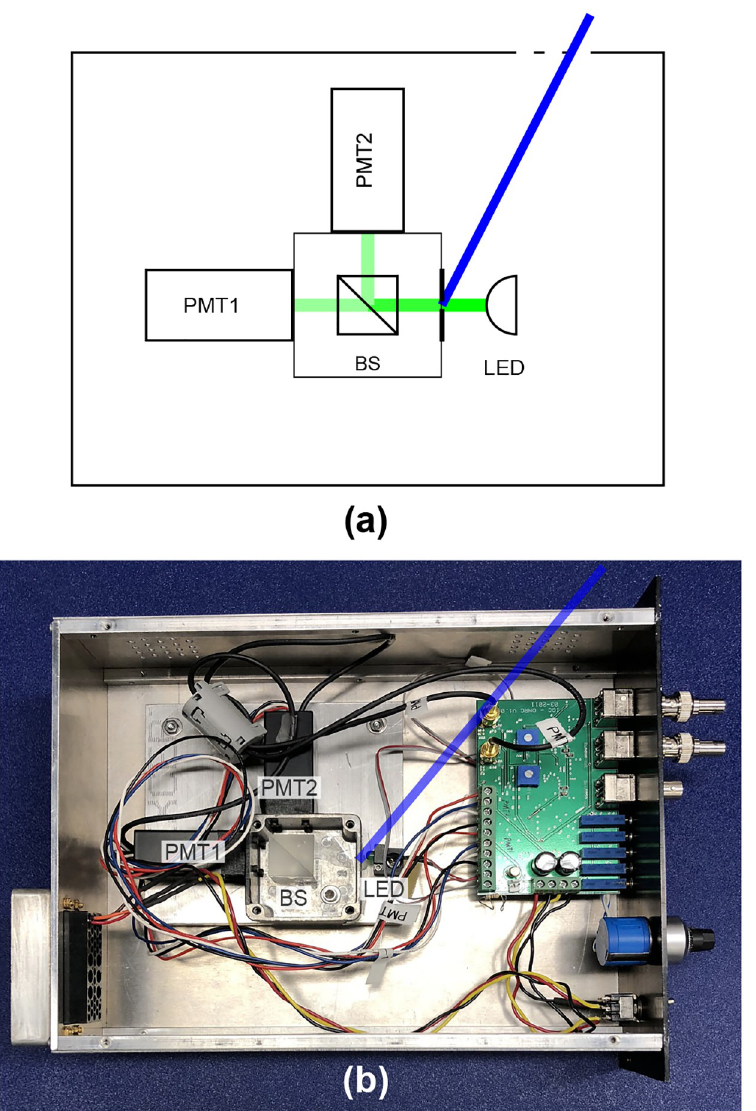
Fig 6. Quantum random number generator under attack. (a) Scheme of the QRNG. Light from a LED (green beam) passes a pinhole and a beam splitter (BS) with two outputs leading to detectors PMT1 and PMT2. For our attack we take advantage of a ventilation hole at the top of the case. With additional light, we can make one detector more likely to click. We show in blue a possible path from the ventilation hole to the pinhole that gives access to the metal box with the BS. (b) Picture of the prototype QRNG [65], with covers removed from the enclosure and beam splitter box. The path to the pinhole has been marked with a blue line.